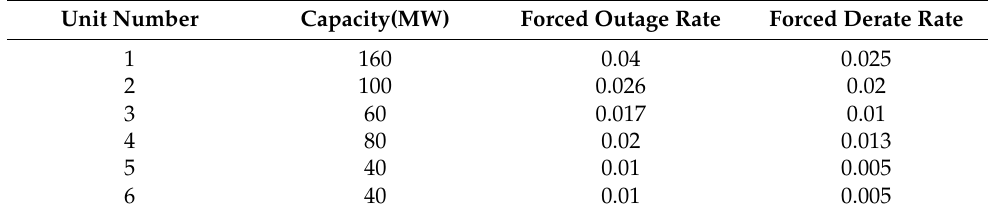
Table 1. Generator set parameters.